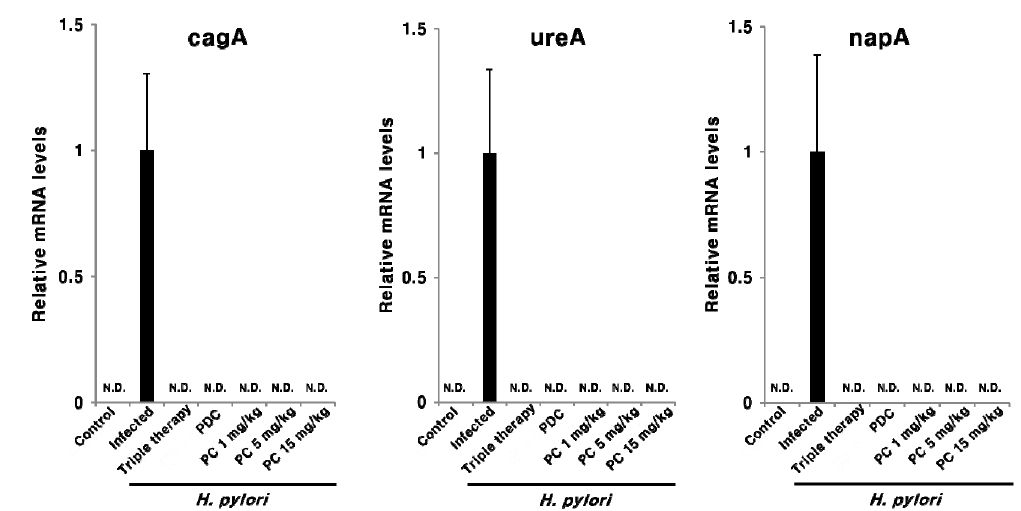
Figure 5. Effect of PC treatment on the expression of H. pylori cagA, ureA, and napA in the gastric tissue of the H. pylori -infected mice. N.D., not detected.